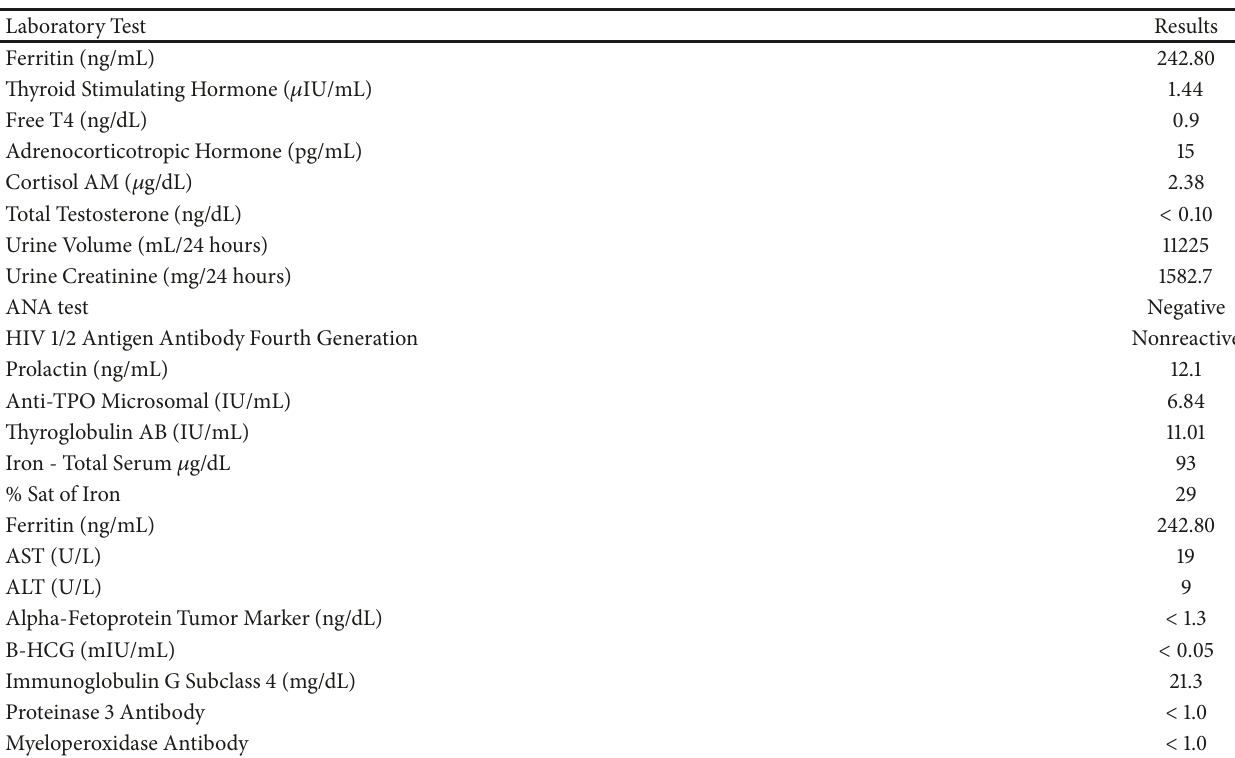
Table 1: Laboratory